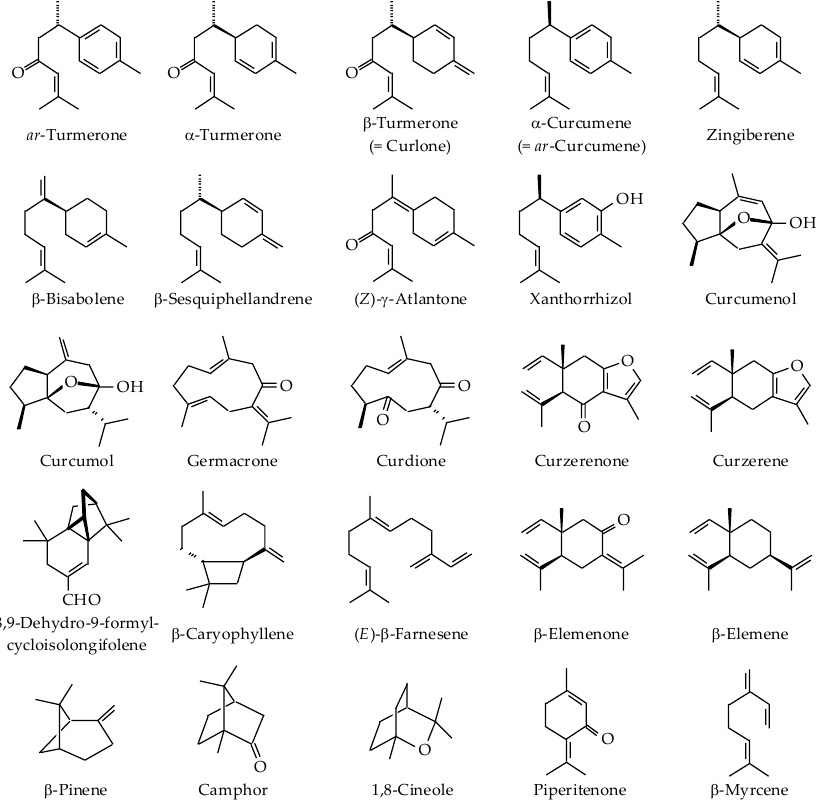
Figure 1. Chemical structures of key volatile components in the essential oil from Curcuma spp.